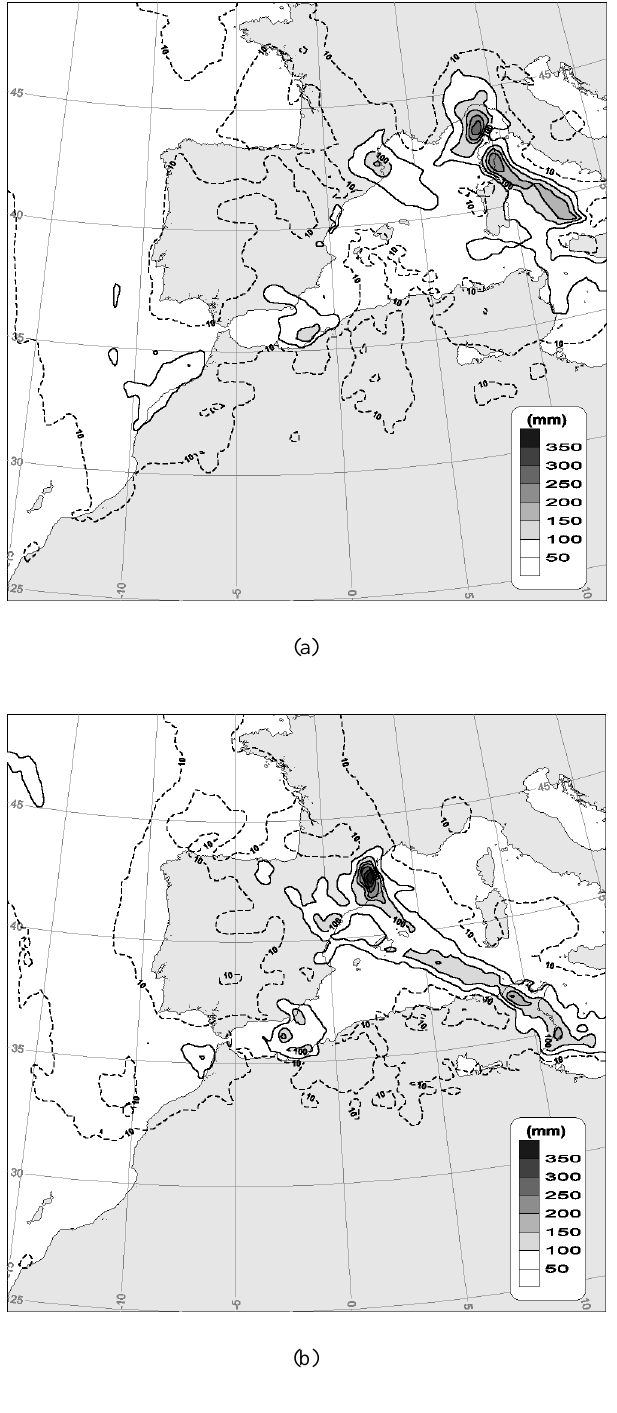
Fig. 24. As in Fig. 7c but for (a) noB and (b) noC experiments. Note the selection of domain 2 to present these fields in order to include the rainfall structure of western Italy, not captured by domain